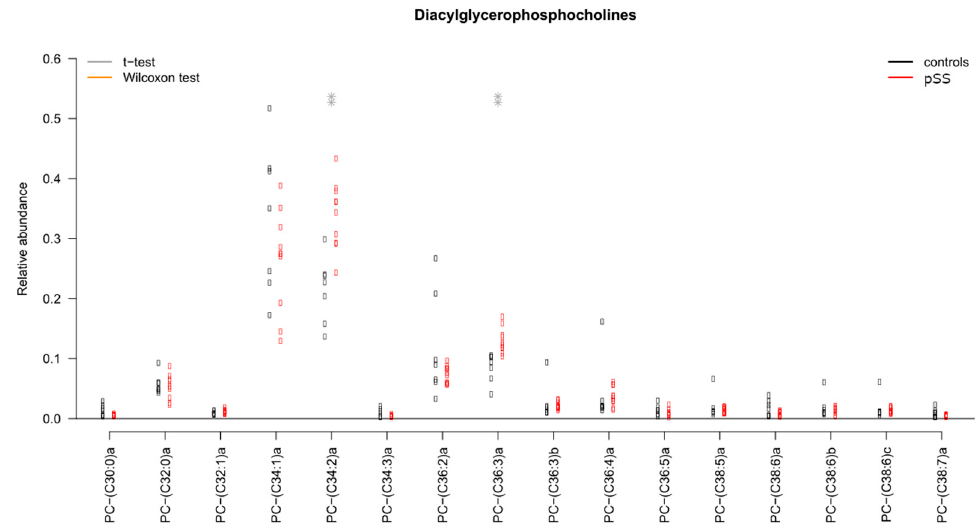
Figure 6. Distribution of individual diacylglycerophosphocholines in tears. ** p < 0.01; pSS: primary Sjögren’s syndrome. Significant chances were found between pSS patients and controls in PC(C34:2)a and PC(C36:3)a. Principal component analysis and subsequent multivariate Fisher tests showed a significant difference in the composition of PC between pSS patients and control subjects ( p = 0.001 (Figure 7). LPC reached borderline significance with a p -value of 0.07. There were no major differences in the overall distribution of nonpolar lipids between pSS patients and control subjects ( p > 0.05).